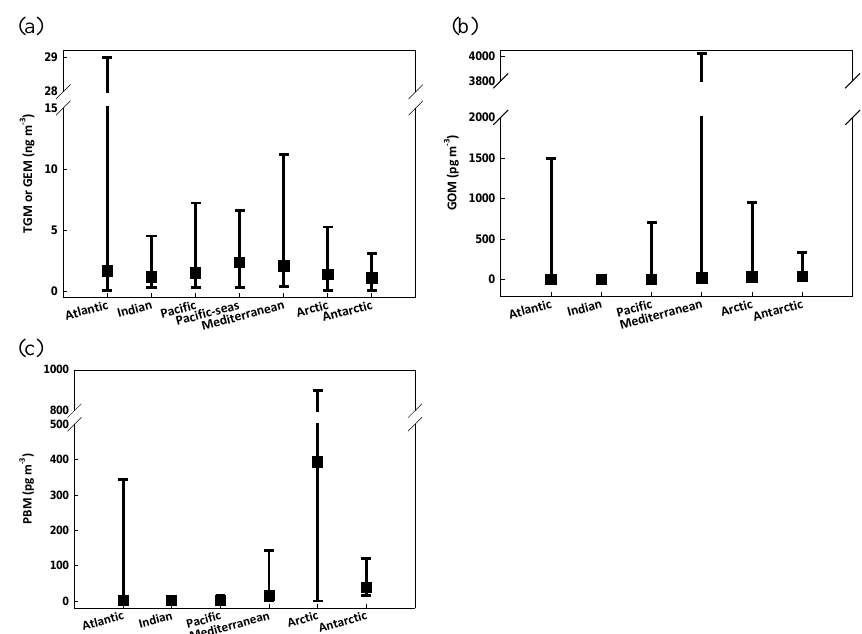
Figure 1. Means and ranges of TGM/GEM (a) , GOM (b) , and PBM (c) concentrations, estimated from the values in the literature as shown in Tables S1–S3, over the Atlantic, Indian, Pacific, seas over the western Pacific (denoted as Pacific-Seas, only TGM/GEM in this category), seas in the Mediterranean region (denoted as Mediterranean), Arctic, and Antarctica Ocean. The solid black squares represent the mean value and the lowest whisker the minimum and the largest the maximum concentration in the region.